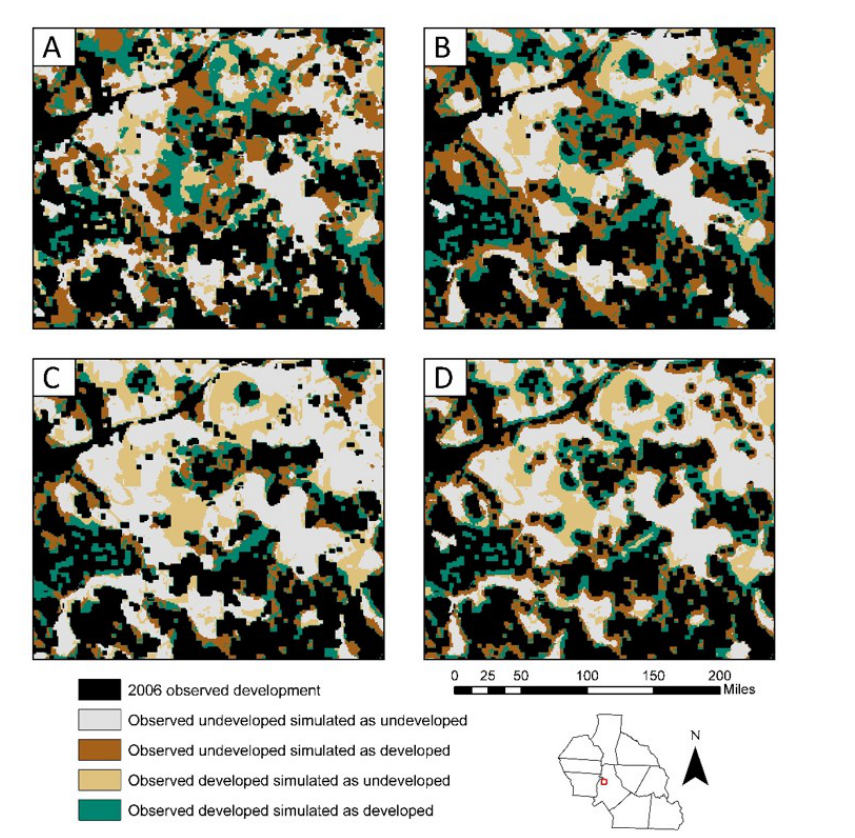
Figure 6. Representative examples of typical spatial patterns created from 2006 to 2016 by: ( A ) FUTURES; ( B ) GEOMOD; ( C ) LCM and ( D ) SLEUTH for a portion of Mecklenburg County,